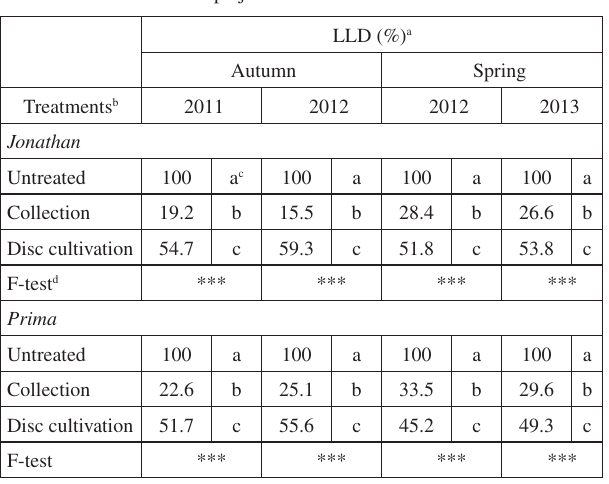
Table 2. Effect of three sanitation treatments on leaf litter density (LLD) in autumn and spring at farm-scale level on cv. Jonathan and cv. Elstar at Eperjeske in